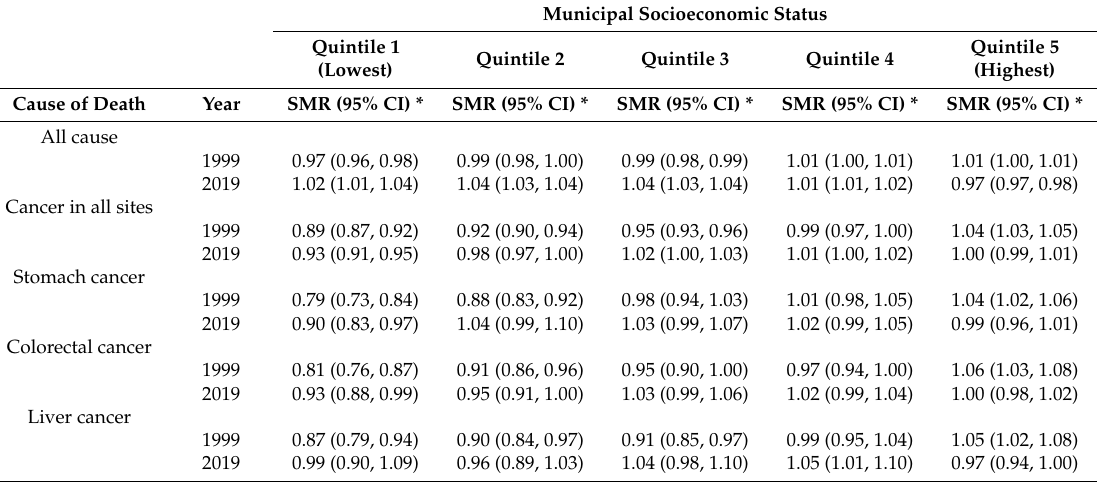
Table 4. SMR for all-cause and each cause of death by municipal SES quintile in 1999 and 2019 for